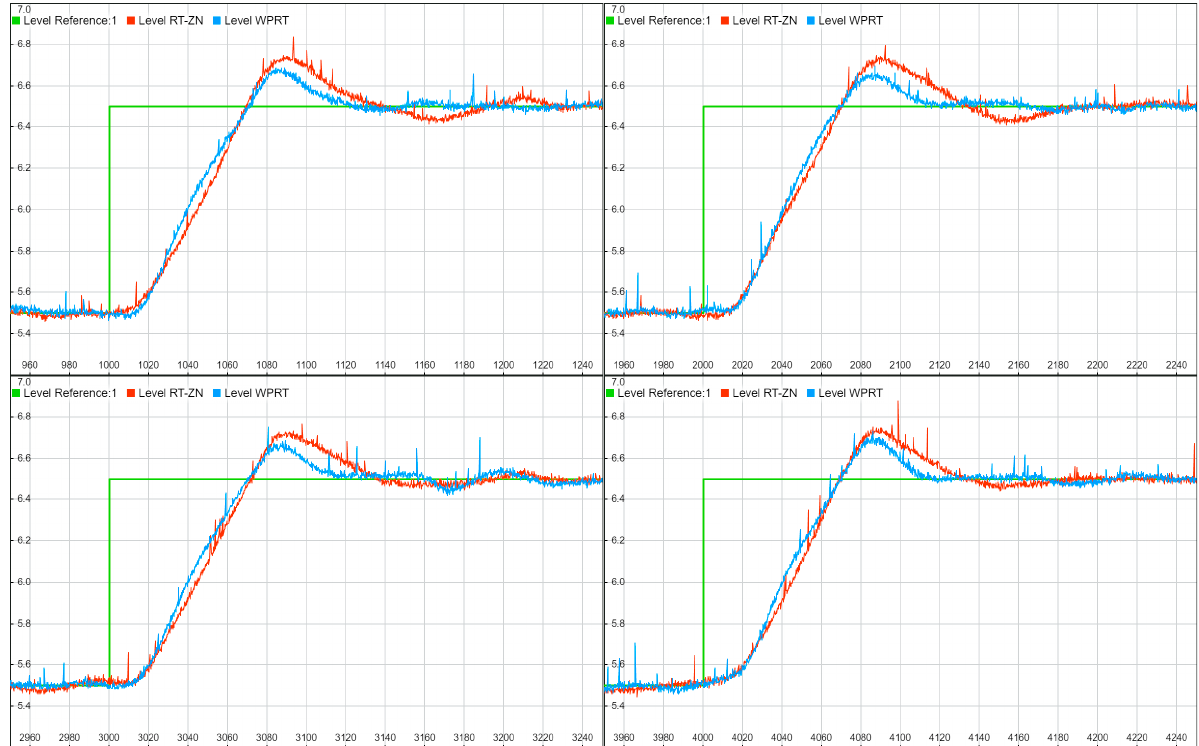
Figure 10. Setpoint change experiment: The water-level setpoint in the separator was changed from 5.5 m to 6.5 m. Water-level setpoint (green), RT-ZN tuning (red), proposed WPRT method (blue).